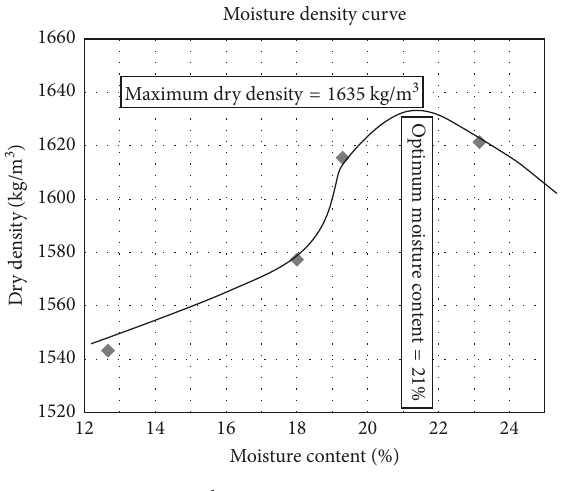
Figure 5: Proctor test result for sand used to construct slope model.